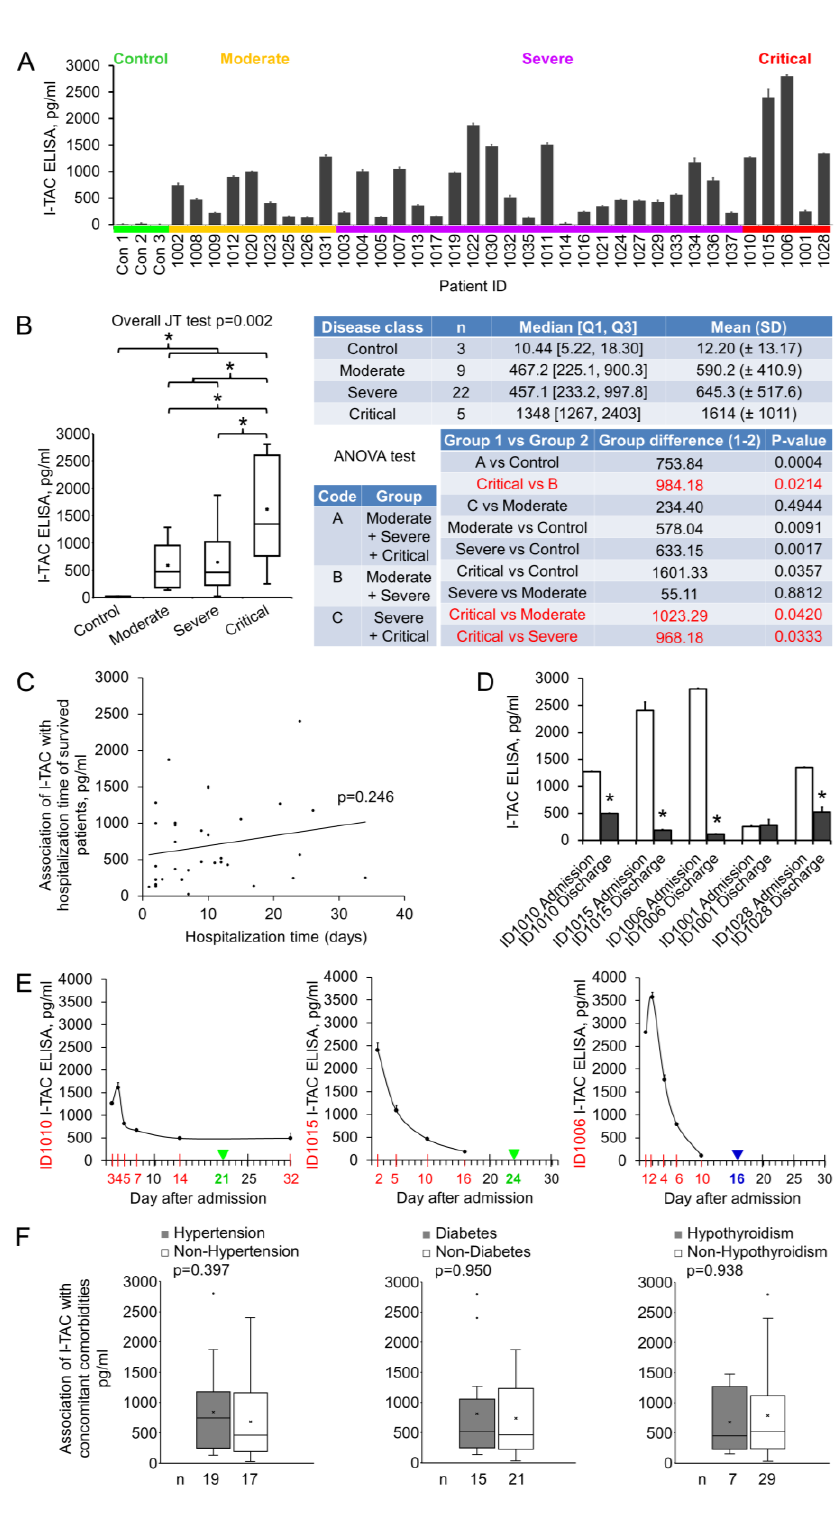
FIGURE 3: I-TAC levels in patient plasma. (A) I-TAC levels were meas- ured using ELISA kits. Early plasma (25 µl) were diluted to 100 µl and added to anti-I-TAC mixture coated wells in duplicate. Data were groups by disease stage and expressed as mean ± SD. (B) Statistical analysis of I- TAC levels with disease stages. (C) Association of early plasma I-TAC levels with hospitalization time